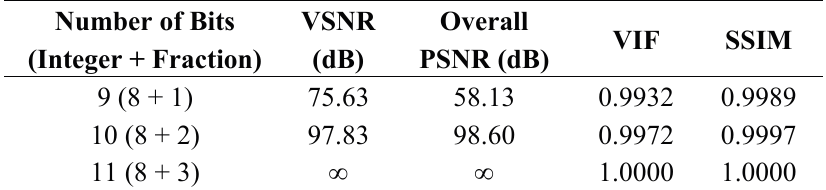
Table 1. Average image quality index for different data bit